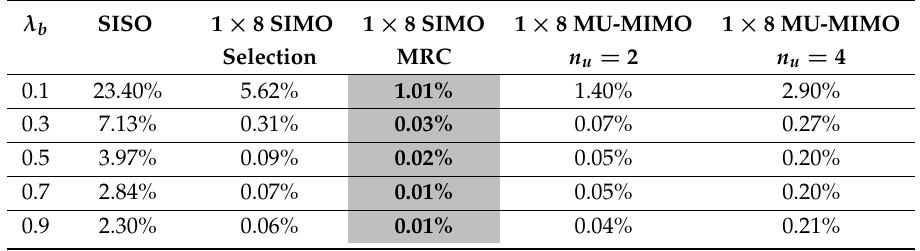
Table 4. Statistical individual OFF probability with regard to antenna configuration, transmission mode and collector intensity λ b .